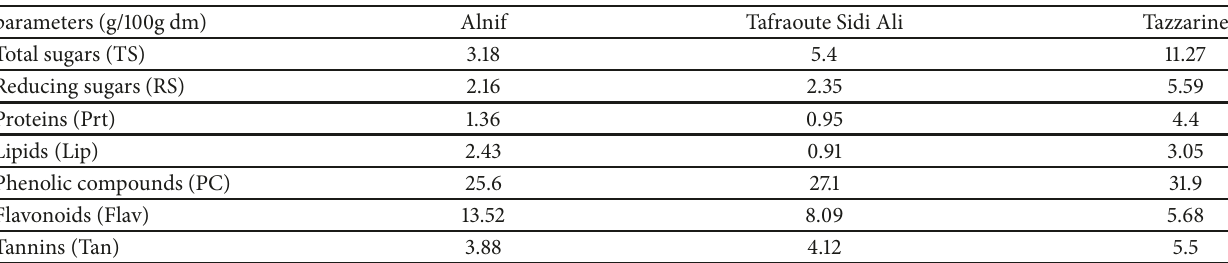
Table 3: Biochemical analysis of the Three Henna varieties